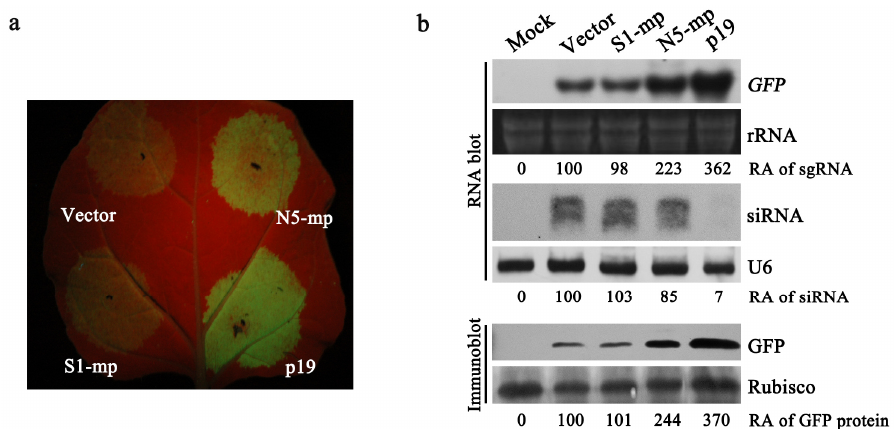
Figure 5. Comparison of N5 and S1 MPs in suppressing local GFP post-transcriptional gene si- lencing. ( a ) Observation of GFP fluorescence under UV light at 3 dpi. The leaves of N. benthamiana were co-infiltrated with Agrobacterium cells containing 35S:GFP and 35S:dsFP (GFP-derived in- verted repeat RNA), together with the cells carrying a vector control, 35S:N5-MP, 35:S1-MP or 35S:p19. ( b ) Analyses of GFP protein, GFP transcripts and GFP-derived small-interfering RNAs (siRNAs) using Western blot and Northern blot, respectively. All these RNAs were detected by DIG-labeled DNA oligonucleotides. Ethidium bromide-stained ribosomal RNAs (rRNAs) were used as RNA loading control for analysis of GFP transcripts. U6 RNA was detected as a loading control. Rubisco protein stained by Ponceau S was used as a loading control. Relative accumulation levels of GFP transcript, GFP-derived siRNA, and GFP protein are shown below. 3.6. The Residue at Position 170 of MP Is the Determinant to the Differential Accumulation of Both ToMV Strains in N. benthamiana To determine the key residue(s) responsible for the differential accumulation of both ToMV strains in host plants, here we aligned the amino acid sequences of N5 MP and S1 MP. The sequence alignment showed that only three residues vary at positions 92, 170, and 240, where N5 MP encodes Met (M), Ile (I), and Tyr (Y), while S1 MP encodes Leu (L), Thr (T) and Asp (D), respectively (Supplementary Figure S2). Subsequently, single or double mutations were introduced into the MP sequence of S1- gfp to generate six mu- tants, S1 92M - gfp , S1 170I - gfp , S1 240Y - gfp , S1 92M170I - gfp , S1 92M240Y - gfp , and S1 170I240Y - gfp . The upper systemic leaves of N. benthamiana plants inoculated with these mutants showed varied GFP fluorescence at 8 dpi (Figure 6a). In these three single mutants, only S1 170I - gfp pro- duced a strong GFP phenotype as did S1 N5-mp - gfp , while the other two were similarly weak to S1- gfp . Both double mutants (S1 92M170I - gfp , S1 170I240Y - gfp ) containing the residue 170I were similar to the single mutant S1 170I - gfp in producing GFP fluorescence (Figure 6a). To further demonstrate the importance of the residue at position 170, reciprocal mutants were made in N5- gfp and tested on N. benthamiana as well (Figure 6b). N5- gfp mutants harboring 170T in single (N5 170T - gfp ) or double mutants (N5 92L170T - gfp , N5 170T240D - gfp ) produced similarly weak GFP fluorescence as did N5 S1-mp - gfp , which was much weaker than N5- gfp or other mutants (Figure 6b) . Taken together, these results in- dicate that the distinct residues at position 170 in MP determine the differential accu- mulation of both ToMV strains.